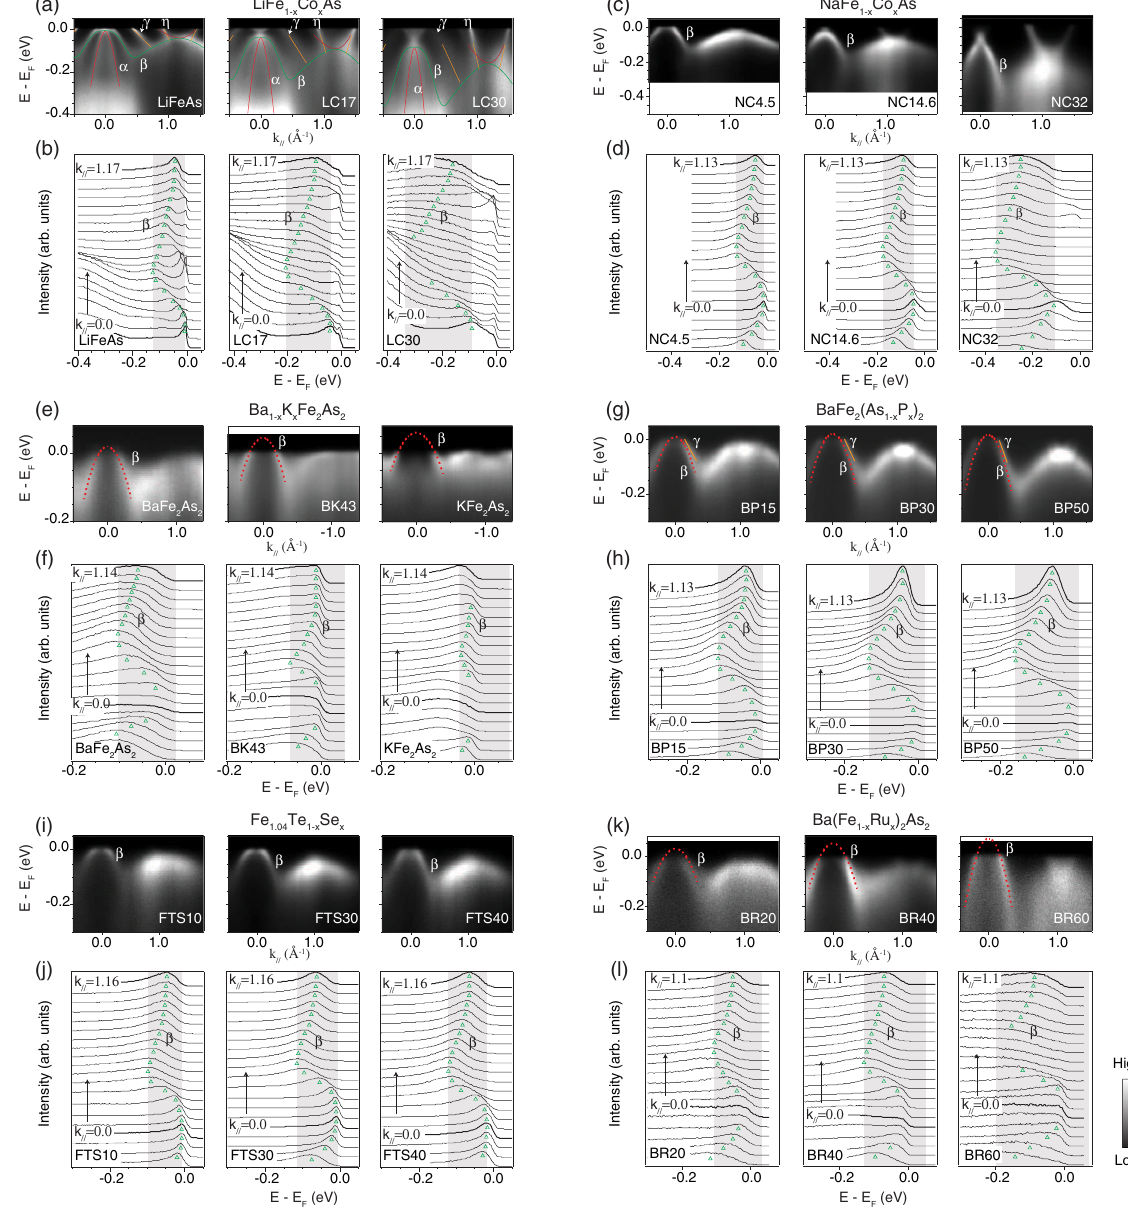
FIG. 3. (a) Doping dependence of the photoemission intensity distributions parallel to the Γ -M direction in LiFe 1 − x Co x As, taken with mixed polarized photons. The band structure was determined based on the photoemission data in LiFeAs. The entire band structure was shifted in energy and normalized by a factor of around 1.6 in LC17 and around 2.2 in LC30. The obtained band structures were overlaid on the photoemission data in LC17 and LC30. (b) Corresponding energy distribution curves (EDCs) of the data in panel (a). The intensities of the EDCs were normalized to enhance the β band. The green triangles trace the band dispersion of β . The gray shaded area is a guide to the eyes for viewing the change of the bandwidth with doping. (c), (e), (g), (i), and (k) Doping dependence of the photoemission intensity distributions taken parallel to the Γ -M direction with s polarized photons in NaFe 1 − x Co x As, Ba 1 − x K x Fe 2 As 2 , BaFe 2 ð As 1 − x P x Þ , Fe 1 Te 1 − x Se x , and Ba ð Fe 1 − x Ru x Þ 2 As 2 , respectively. The photoemission data for each series are from the same k z , . 04 although the bandwidth varies little with k z as reported before [9]. Note that the red dashed lines overlaid on panels (e), (g), and (k) are the quadratic-curve-fitting results for the β bands, in order to determine the energy positions of β band tops. Panels (d), (f), (h), (j), and (l) are the same as (b), but for NaFe 1 − x Co x As, Ba 1 − x K x Fe 2 As 2 , BaFe 2 ð As 1 − x P x Þ , Fe 1 Te 1 − x Se x , and Ba ð Fe 1 − x Ru x Þ 2 As 2 , . 04